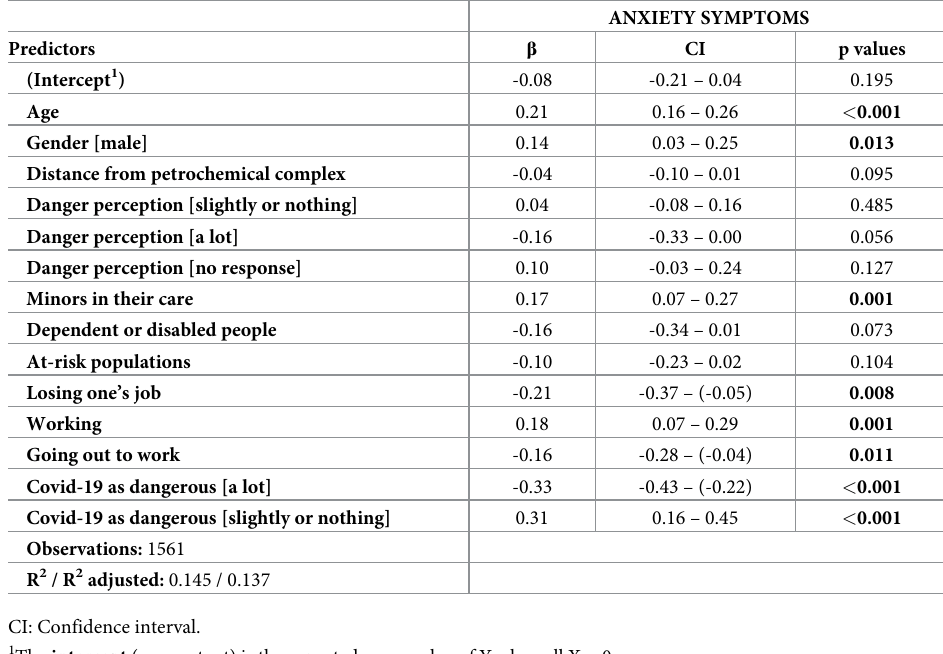
Table 12. Regression analysis relating to anxious symptomatology in the HADS.